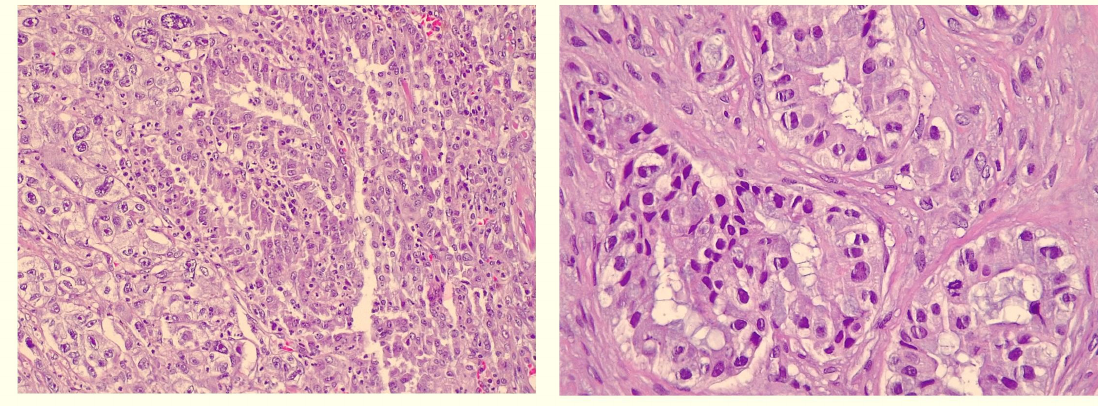
Figure 4. MAC of the lung.